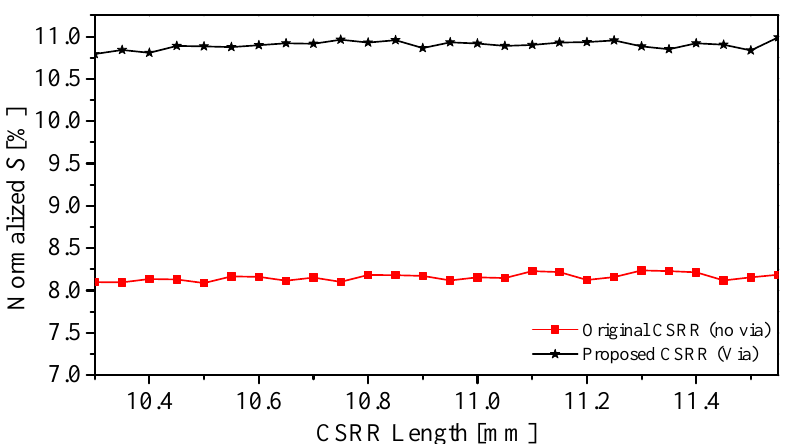
Figure 7. The normalized sensitivity versus the resonator’s length, which is varied from 10.3 to 11.55 mm for the original CSRR sensor and the proposed CSRR sensor.